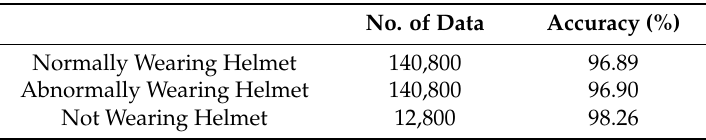
Table 5. Results of analysis of the recognition accuracy and number of data for properly wearing, not wearing, and improperly wearing the safety helmet for each worker